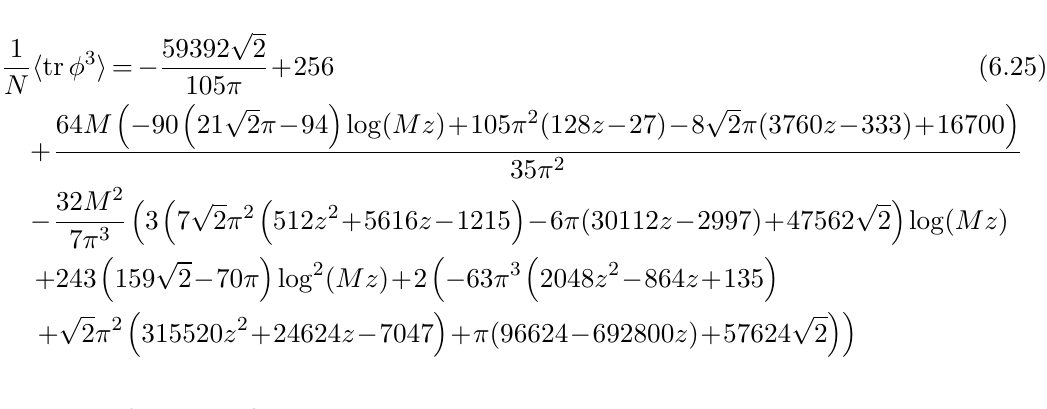
JHEP03(2023)067